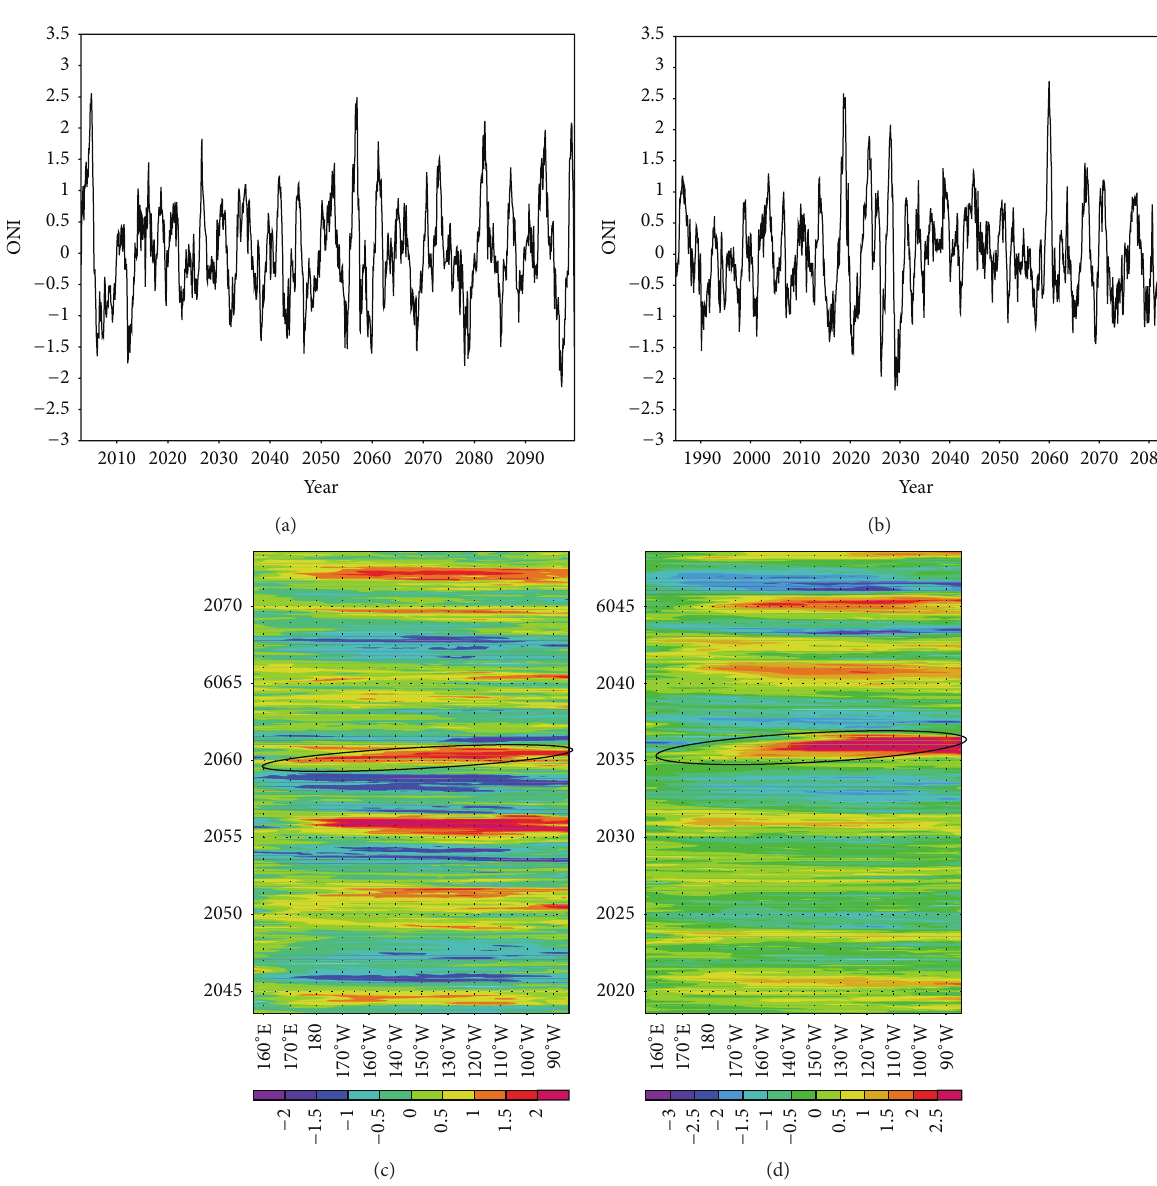
Figure 3: ONI for (a) CMIP1 and (b) like (a) but for CMIP2. (c) Hovm¨oeller SST diagram for CMIP1 and (d) like (c) but for CMIP2. Circled areas show a typical ENSO event.